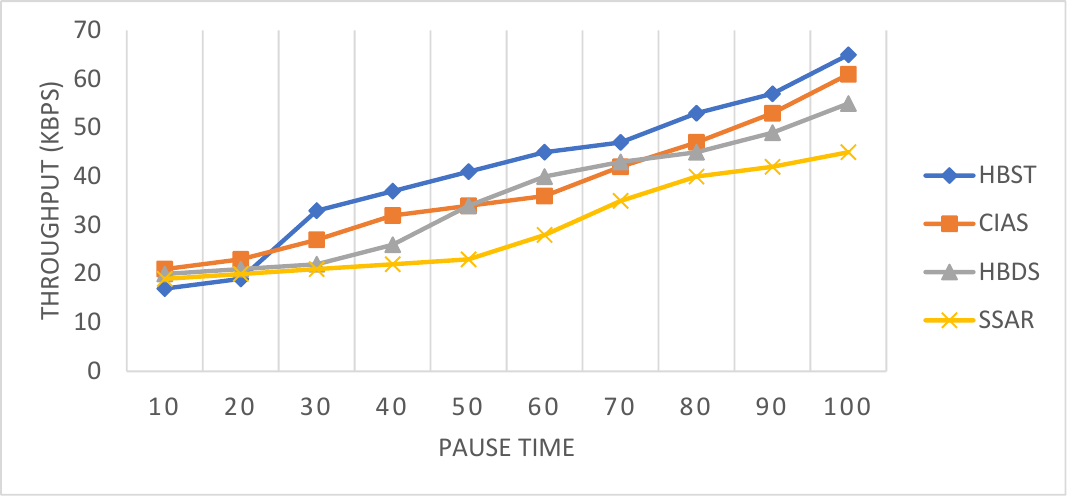
Figure 6. Throughput for the network with 50% selfish nodes.